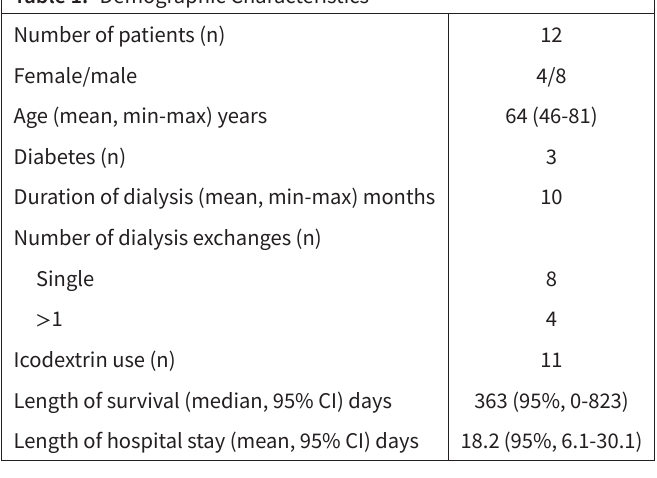
Table 2. Baseline Clinical and Laboratory Characteristics